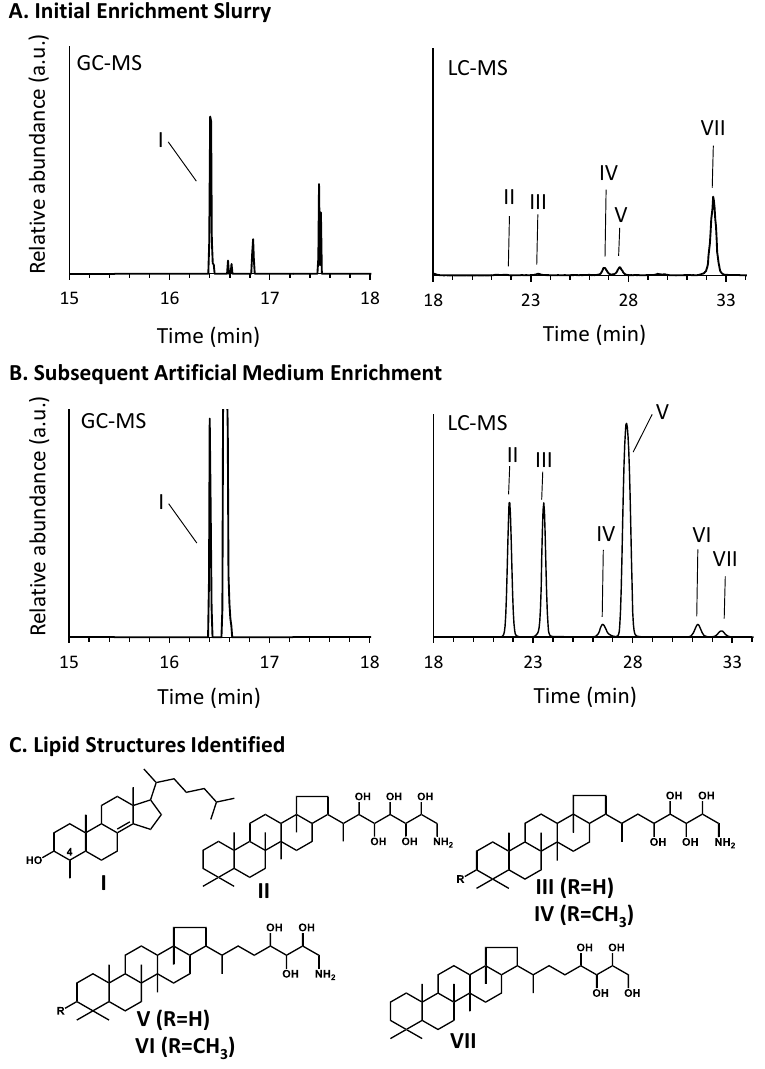
Figure 3. Detection of aerobic methanotroph sterols and hopanoids in Herman Pit enrichment samples. GC-MS extracted ion chromatograms ( m / z 442) showing production